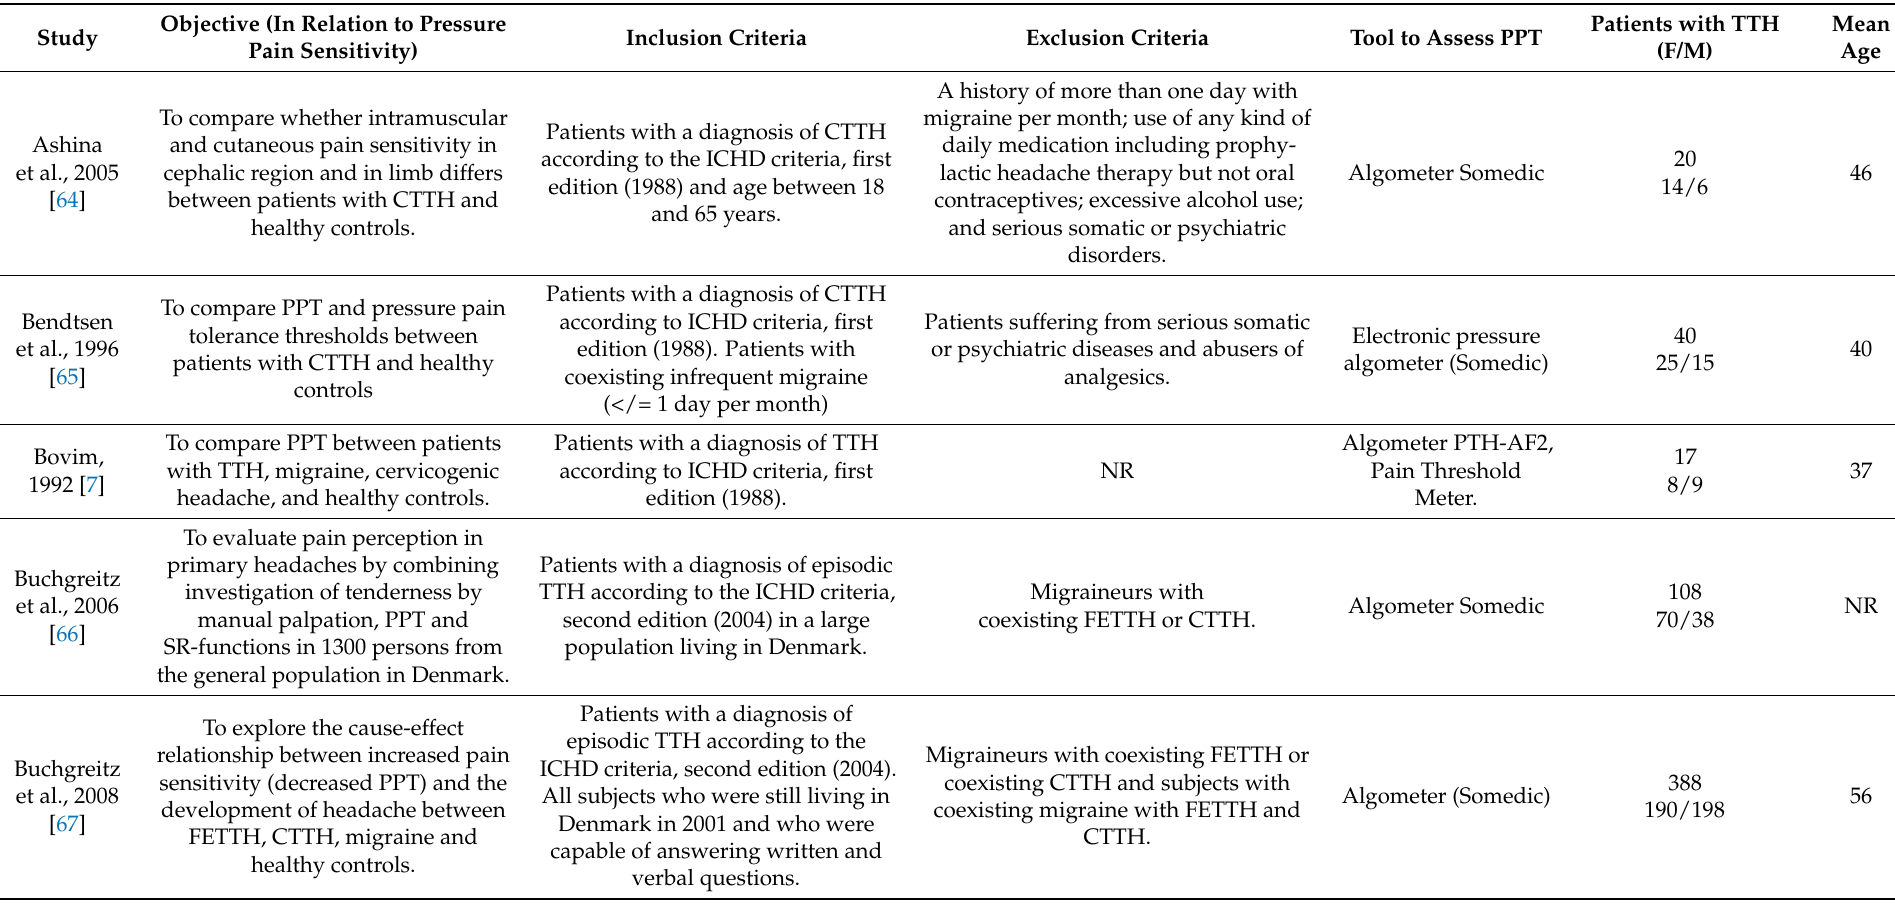
Table 3. Characteristics of studies including women with tension-type headache